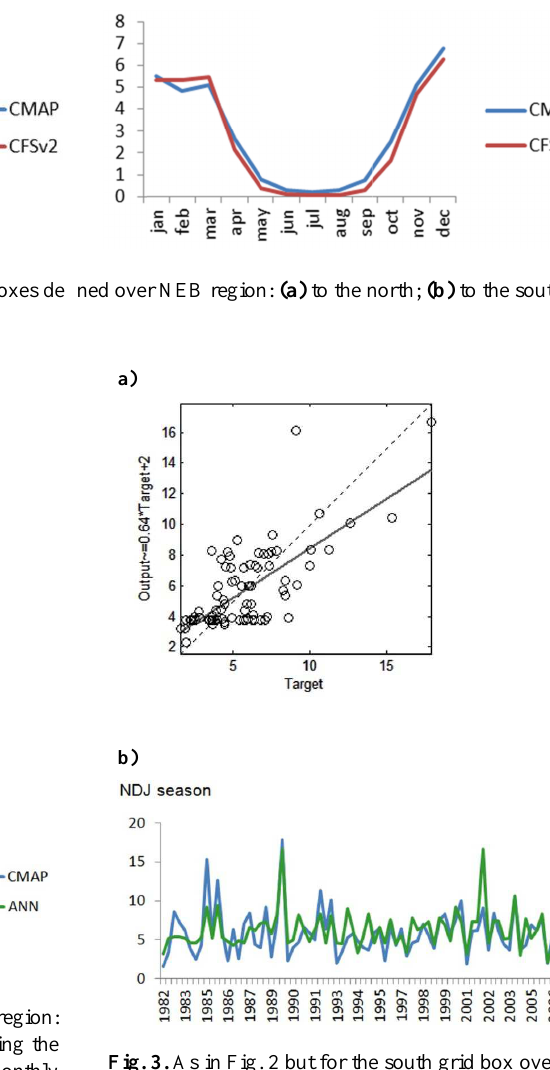
Fig. 3. As in Fig. 2 but for the south grid box over the NEB region. Figure 3. 1 In (a)